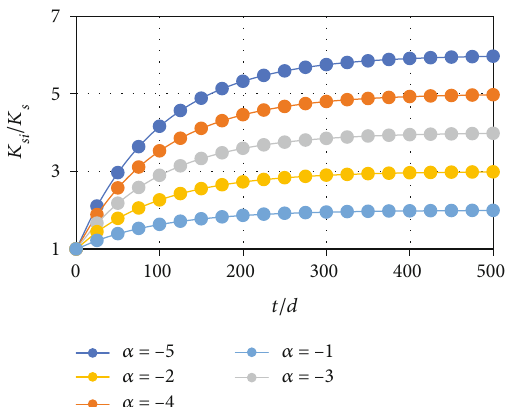
Figure 10: Relationship between K